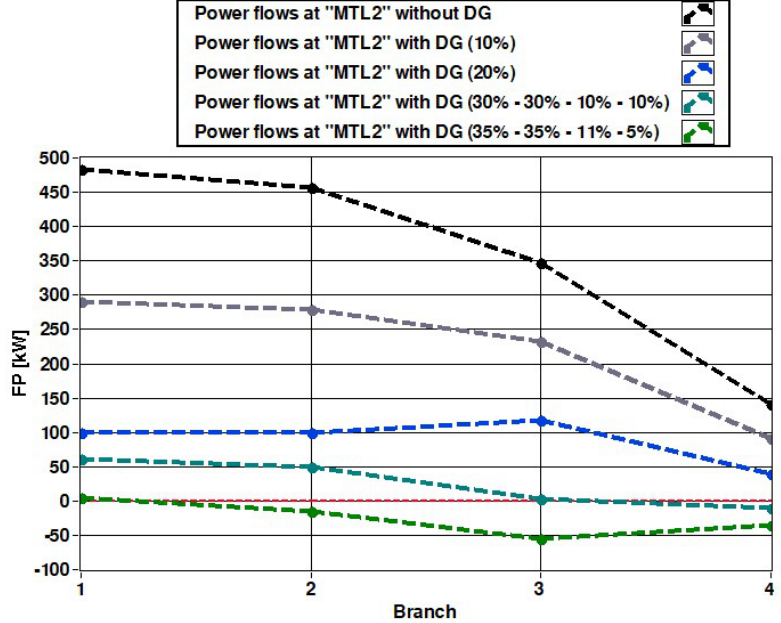
Figure 23. Active power flows of the “MTL2” line as the power fed by the distributed generation (DG) changes (31 May 2018 at 1:00 pm).